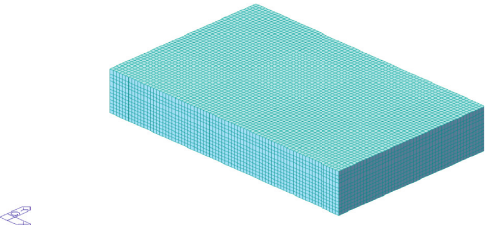
Figure 4: Cap model drawing.